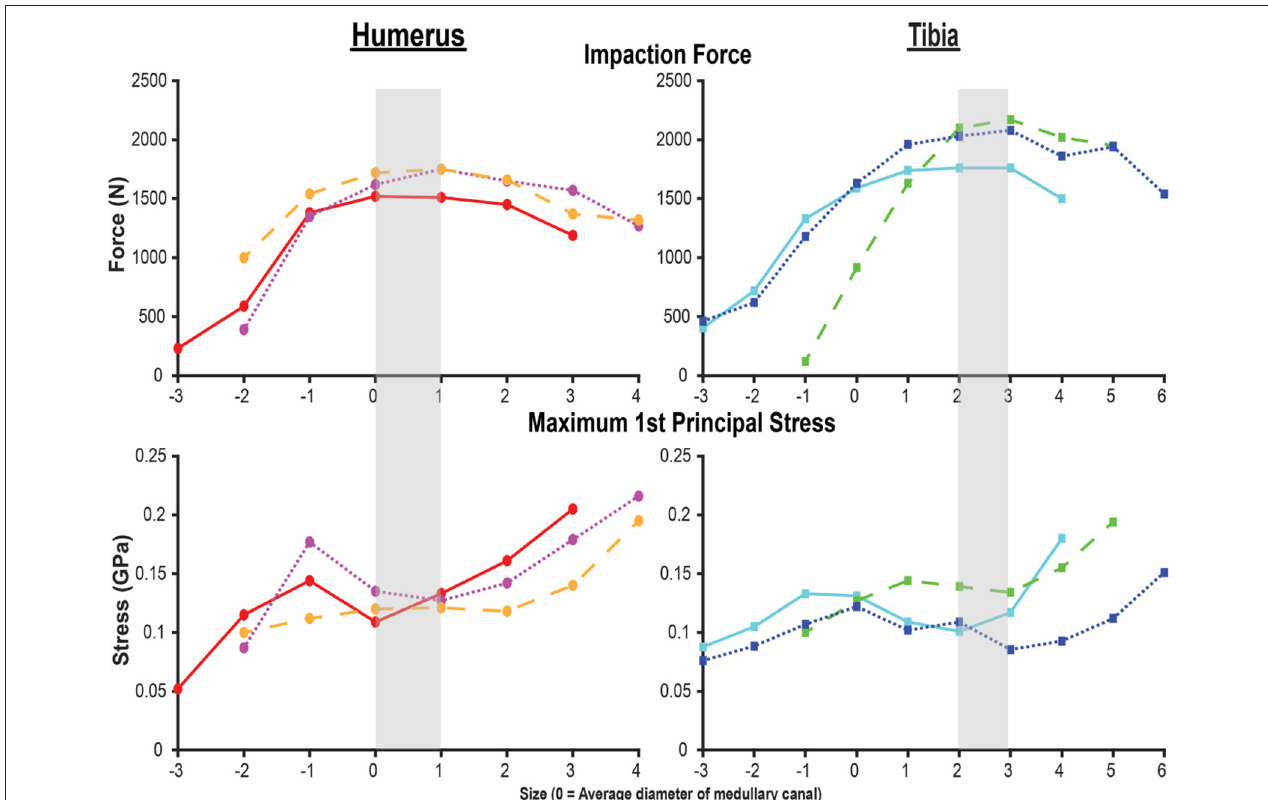
FIGURE 3 | Final impaction force (top) and maximum first principal stress (bottom) for the humerus (left) and tibia (right) finite element analysis (FEA) models. X-axis is the endoprosthesis size normalized to the average diameter of the medullary canal. Each line represents one of the three humeri and tibiae modeled by FEAs. Shading indicates sizing that maximizes impaction force while minimizing stress. Small peaks and valleys in the overall pattern occurred in areas of a subject-specific feature of the medullary